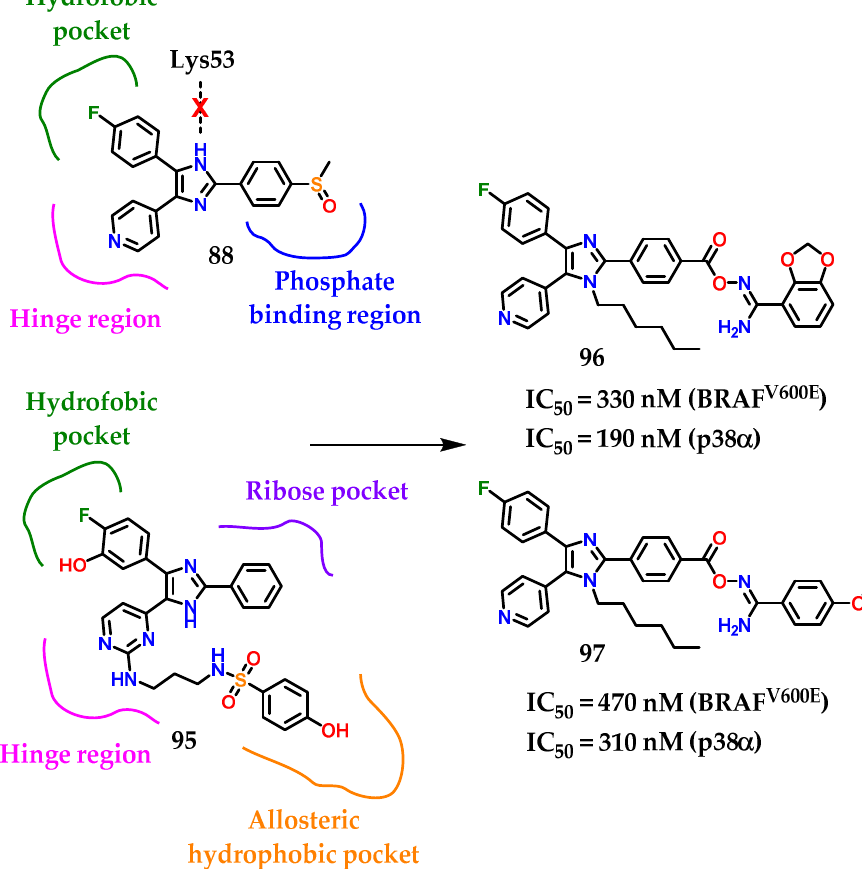
Figure 37. Rational design of compounds 96 and 97 .